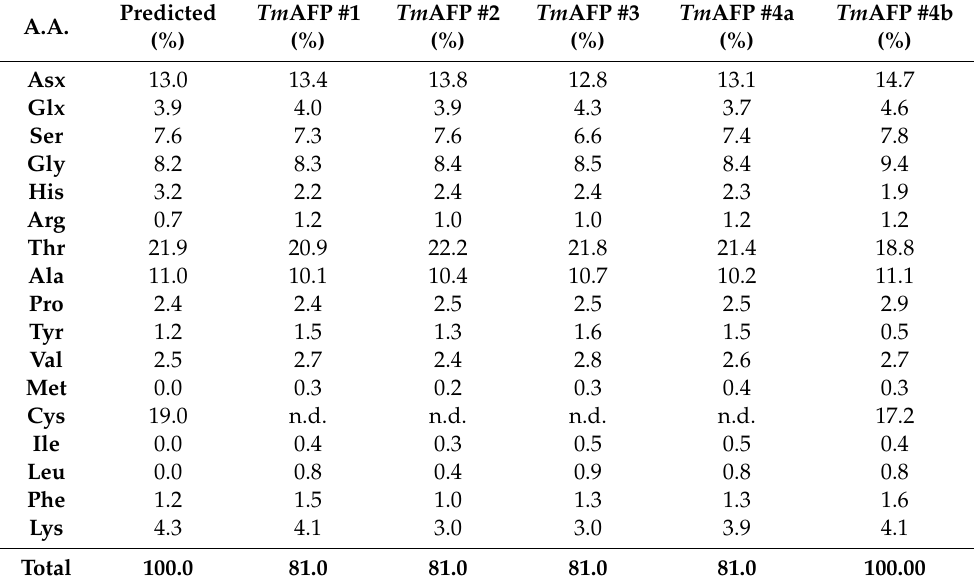
Table 2. Percent amino acid composition of four Tm AFP preparations (1–4). Tm AFP #4a and 4b were analyses done on the same sample, but with cysteine oxidized to cysteic acid in 4b to measure its